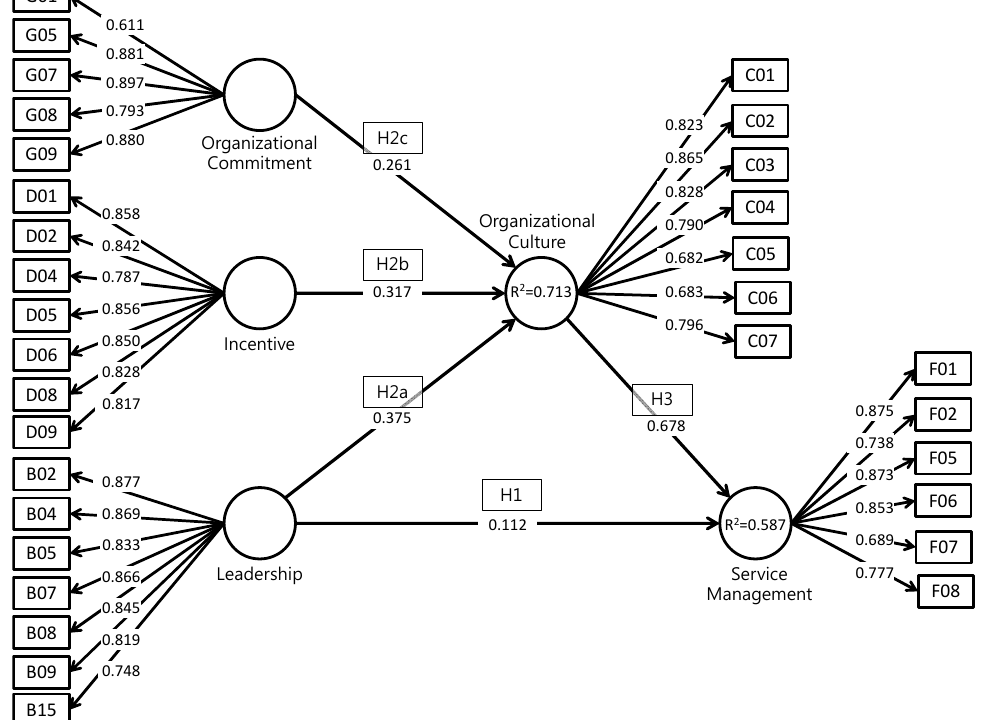
Figure 4. PLS model (outer loadings, path coefficient, and R 2 ).